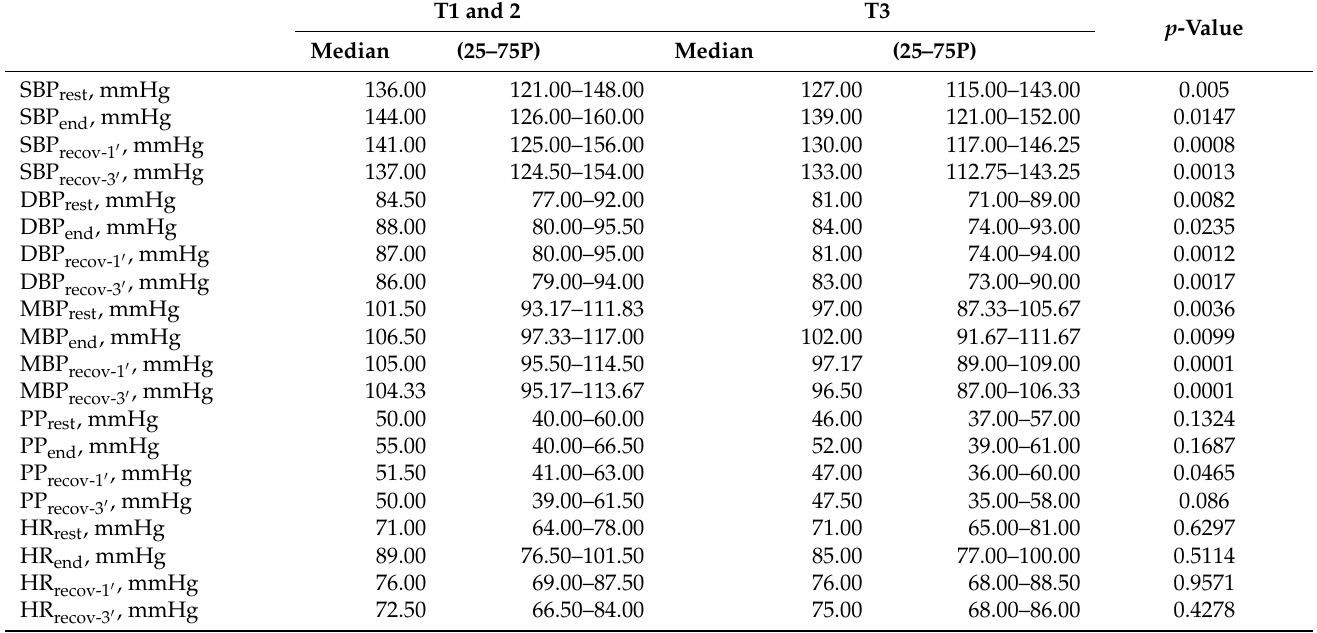
Table 3. Comparisons between patients from T1–T2 and T3 groups at rest, the end of the 6 min walk test (6MWT), and 1 and 3 min post-exercise recovery for systolic blood pressure (SBP), diastolic blood pressure (DBP), mean blood pressure (MBP), pulse pressure (PP) and heart rate (HR) in both groups. Data are presented as median and (25–75P), and comparisons were made with the Mann–Whitney